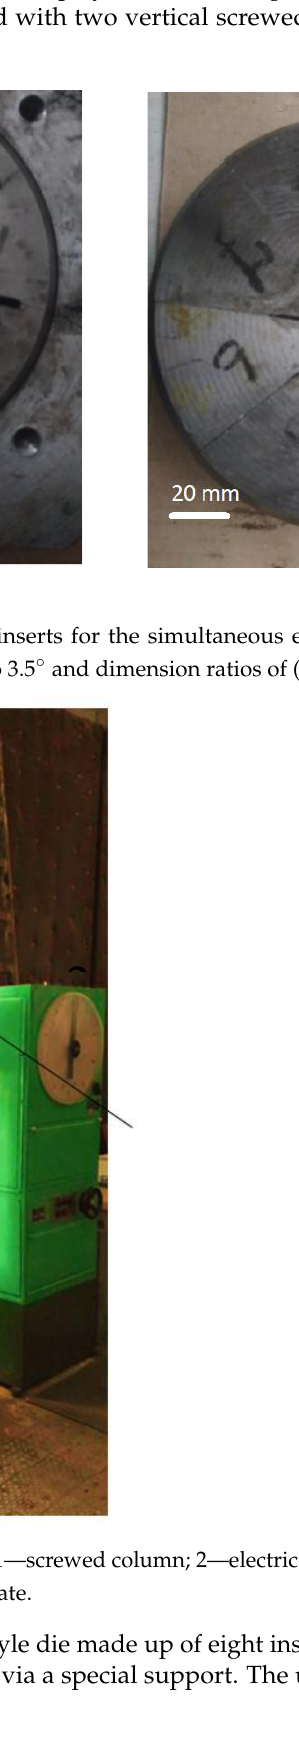
Figure 6. Hydraulic press PSU-250: 1—screwed column; 2—electric motor; 3—analog dial; 4—mobile traverse; 5—top plate; 6—bottom plate.